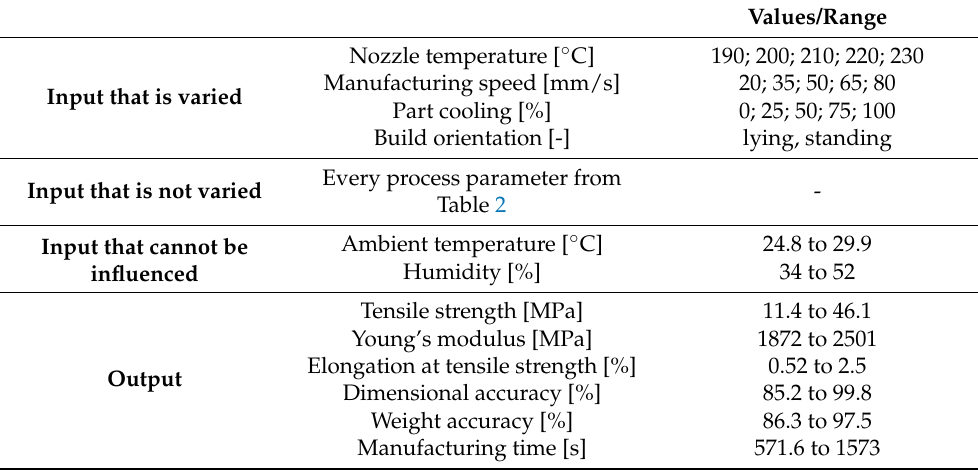
Table 3. Data used to train the